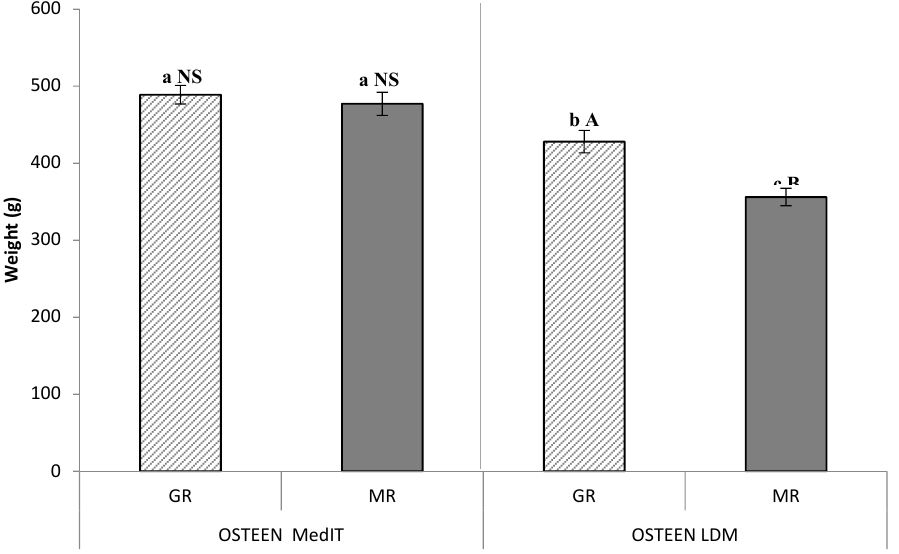
Figure 1. Evolution of fruit weight in green-ripe (GR) and mature-ripe (MR) fresh Mediterranean Italian (MedIT) and imported (LDM) “Osteen” mango fruit. Values represented as mean ± SE ( n = 30). Different lowercase letters indicate significant differences between imported and fresh Mediterranean Italian mango fruit (GR and MR). Different uppercase letters indicate significant differences between mature-green (GR) and mature-ripe (MR) stages in the same series, fresh Mediterranean Italian fresh mango fruit or imported (Osteen MedIT or Osteen LDM).